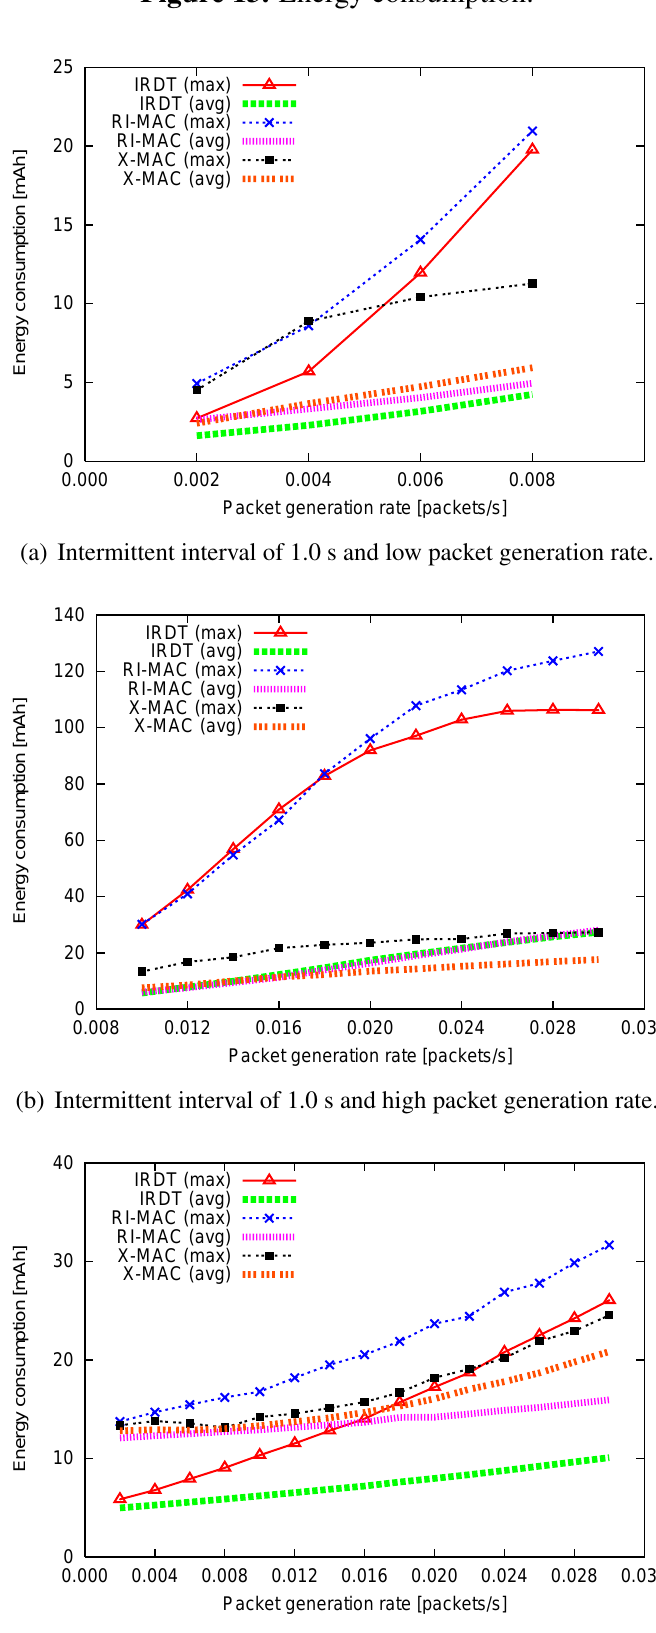
Figure 13. Energy